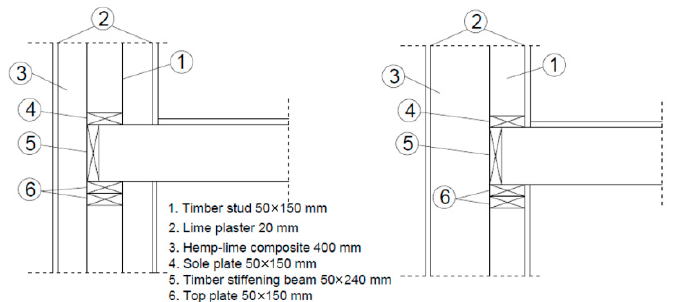
Figure 4. Connection of the wall and ceiling in two cases: with the timber frame located centrally in relation to the wall thickness (on the left ) and located on the inner side of the wall (on the right ).